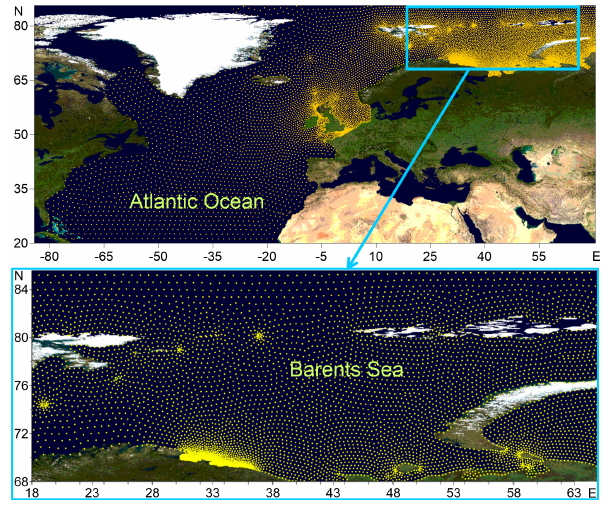
Figure 1. The computational unstructured grid for the Atlantic Ocean and the Barents Sea. The base map is the Blue Marble image obtained by connecting to the WMS Demo Server in the Golden Software Surfer program.